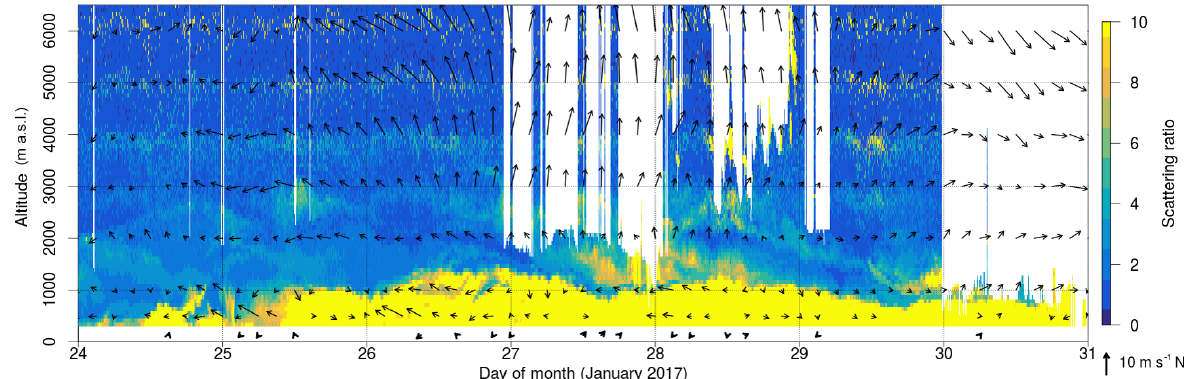
Figure 10. Vertical profile of scattering ratio from the ALC in Milan (24–30 January 2017). Arrows: horizontal velocity of the wind measured at the surface (bold, lower arrows) and simulated by COSMO at several elevations (thin